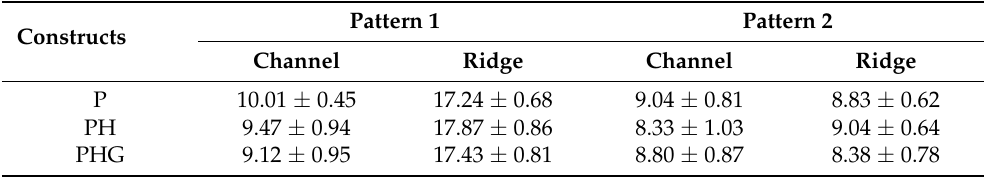
Table 4. Measured pattern sizes (in µ m) for P, PH and PHG